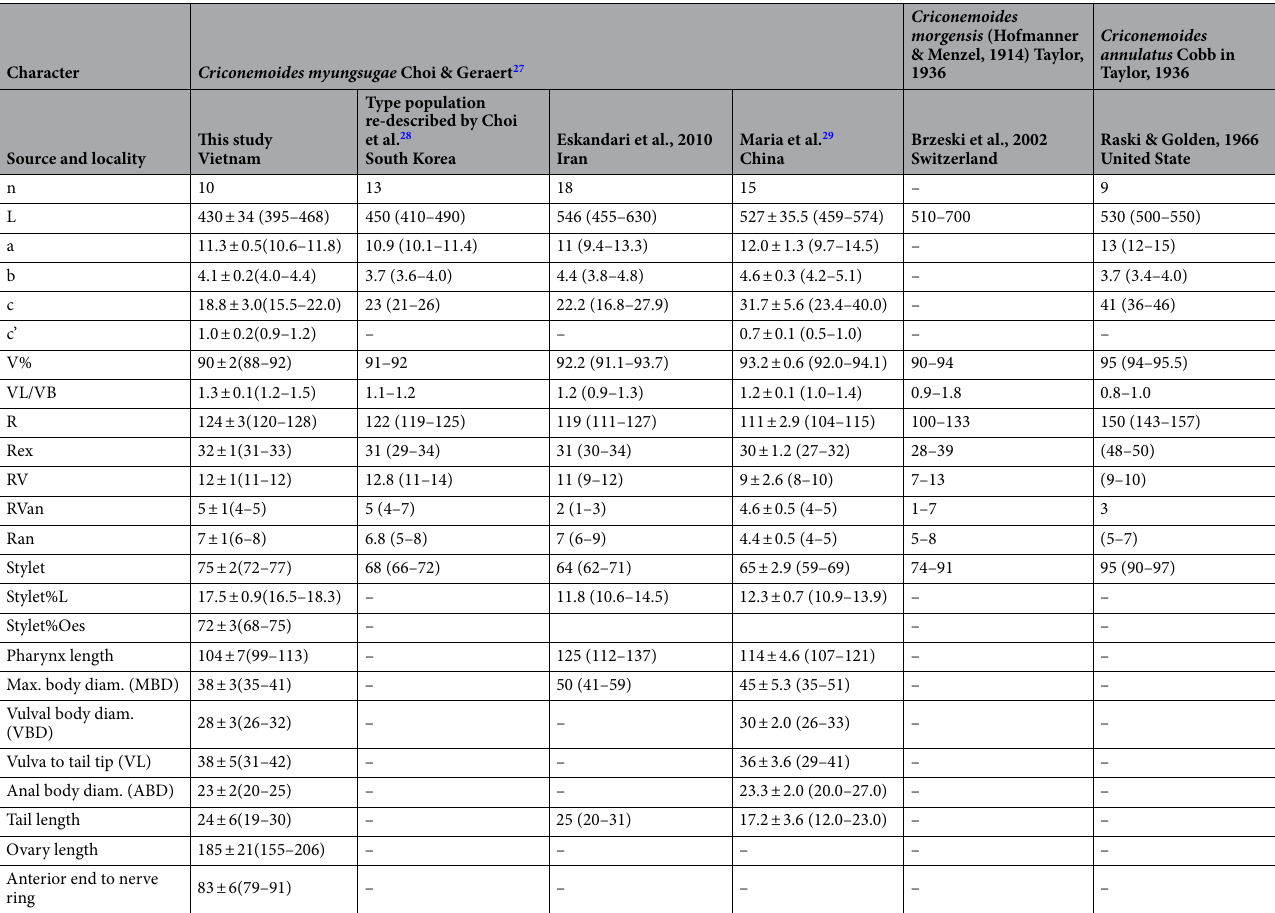
Table 1. Morphometrics of Criconemoides myungsugae from Vietnam and the world. Measurements are in μm and in the form: mean ± s.d.